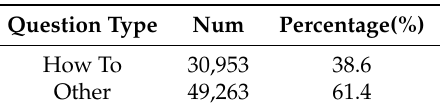
Table 2. Question type